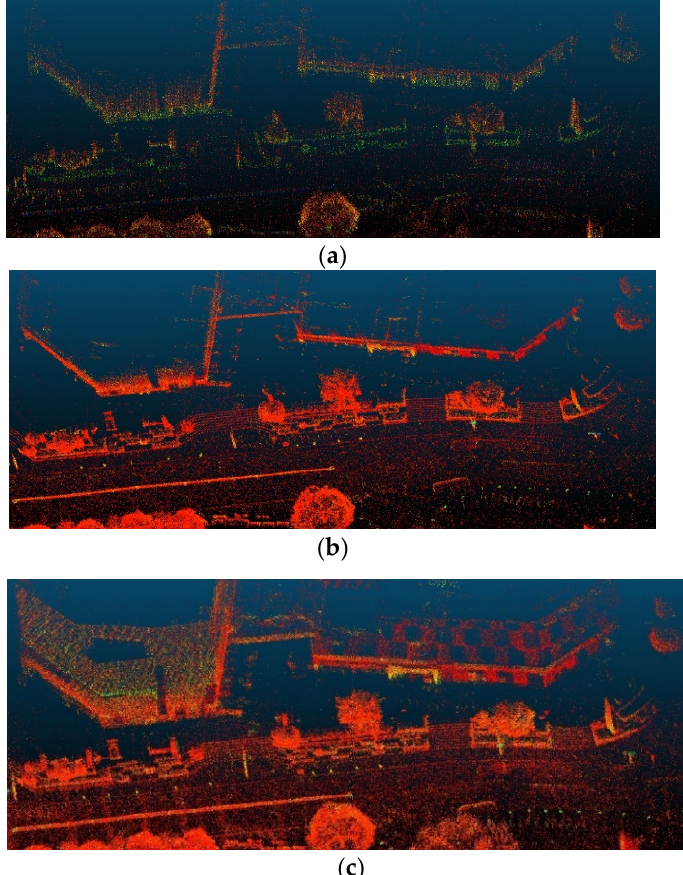
Figure 16. Comparison of mapping details in the city street scene showing that ( a ) the mapping of LeGO-LOAM lacks structural details of the building, ( b ) the mapping of LIO-SAM lacks the height of the building structure, and ( c ) the mapping of HSDLIO provides finer structural details of the building.